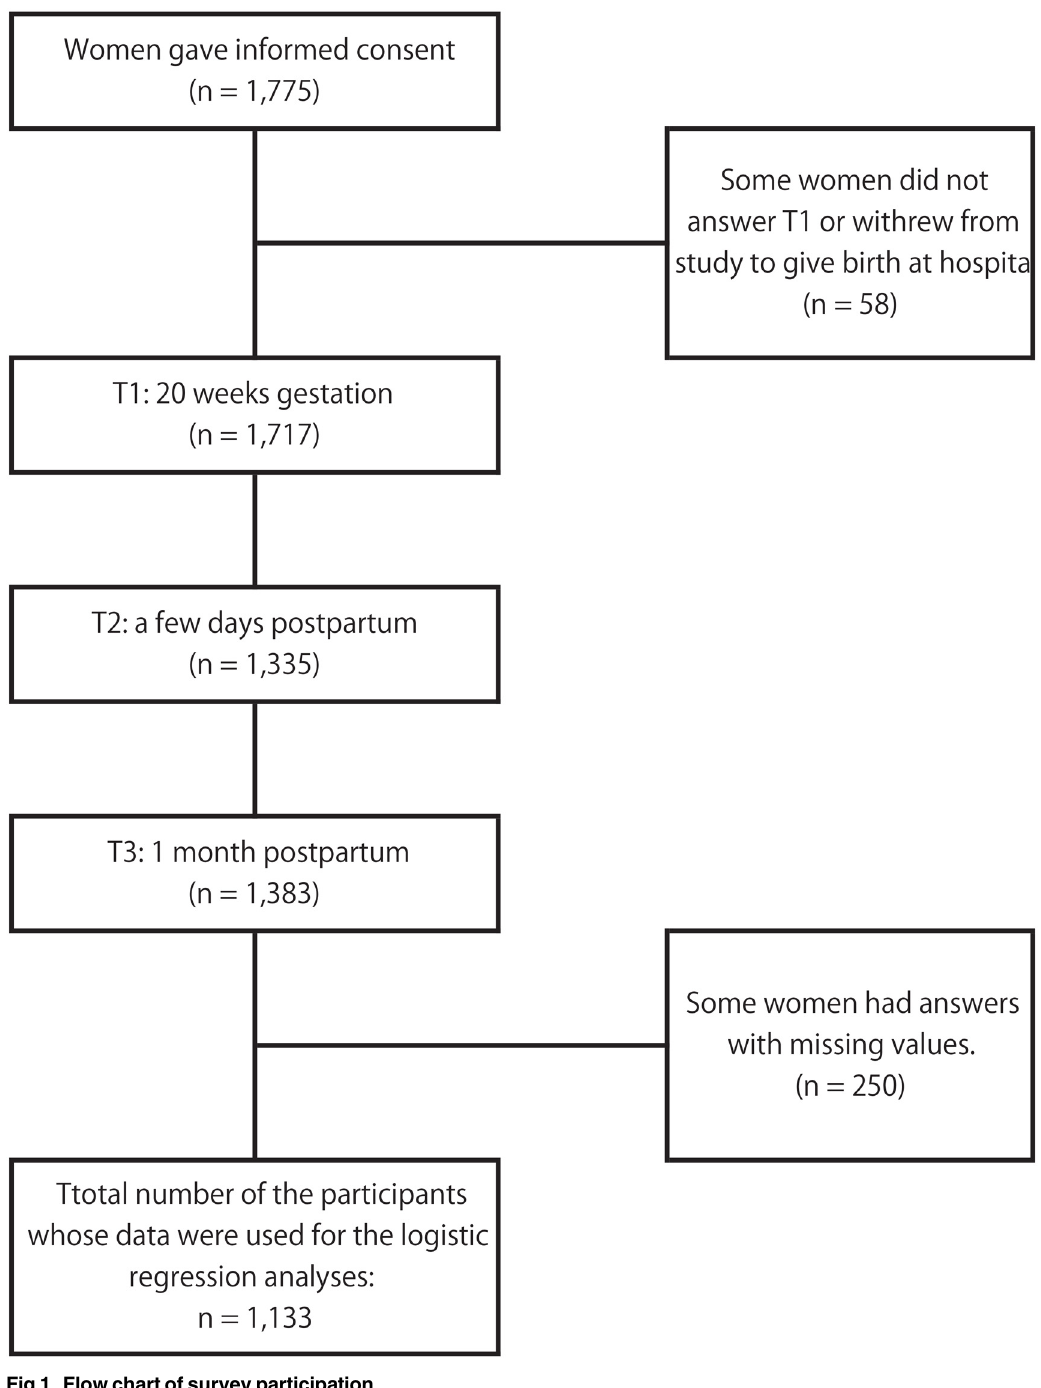
Fig 1. Flow chart of survey